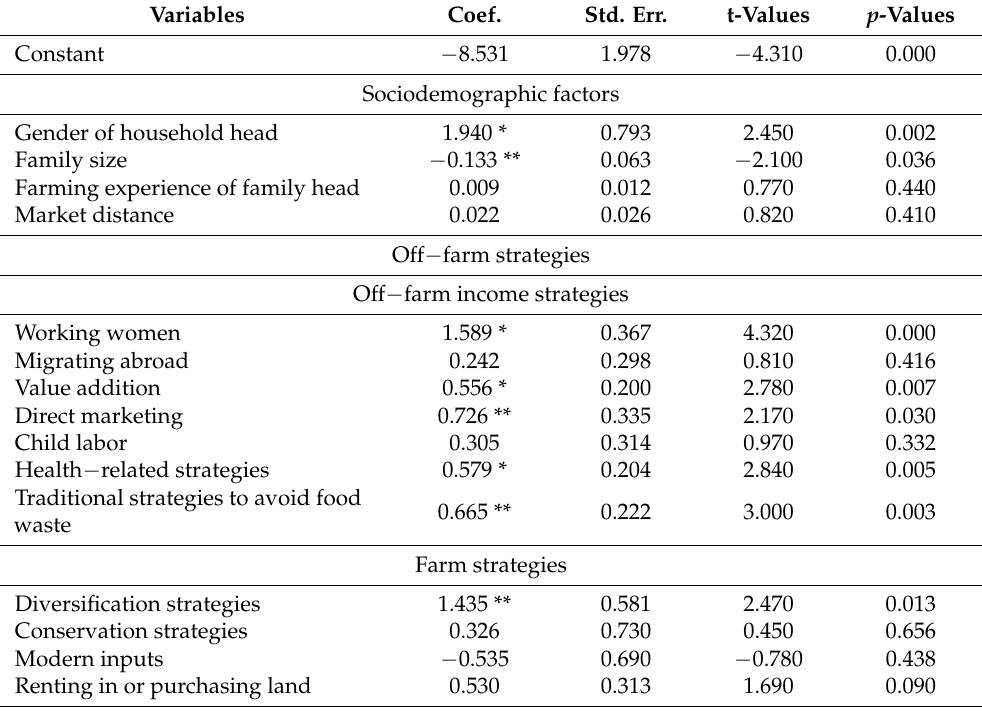
Table 3. Association of household-level adopted strategies with the FNS of the rural families. Coef. Std.